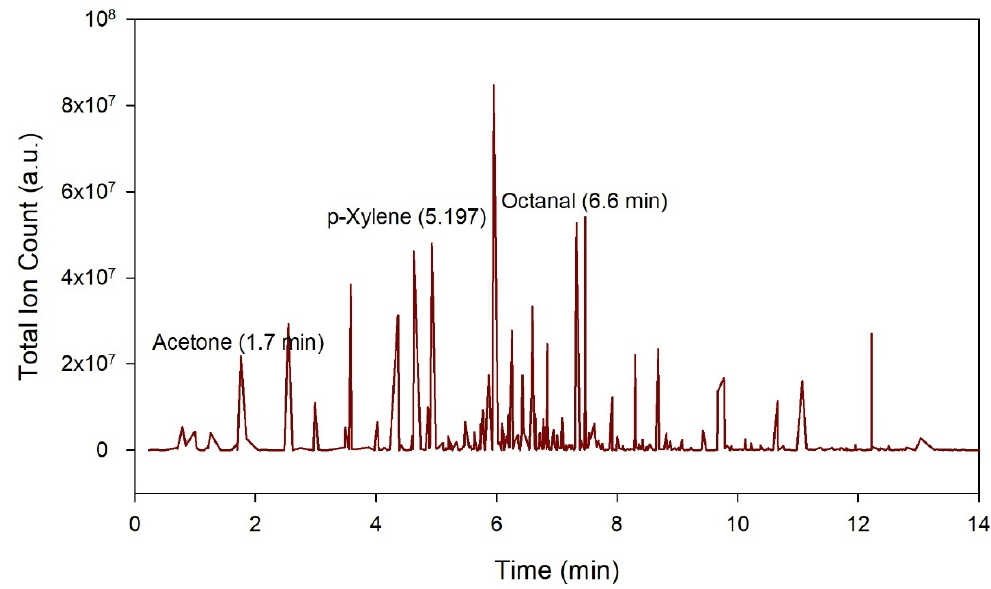
Figure 5. ROC for CRC vs. Non-Cancerous using ( a ) Neural Network and ( b ) Random Forest classifiers for PEN3.